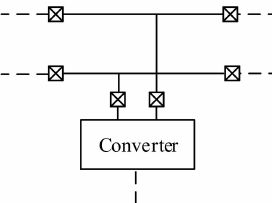
Figure 1. An existing DCCBs (DC circuit breakers) installation method in a DC microgrid.